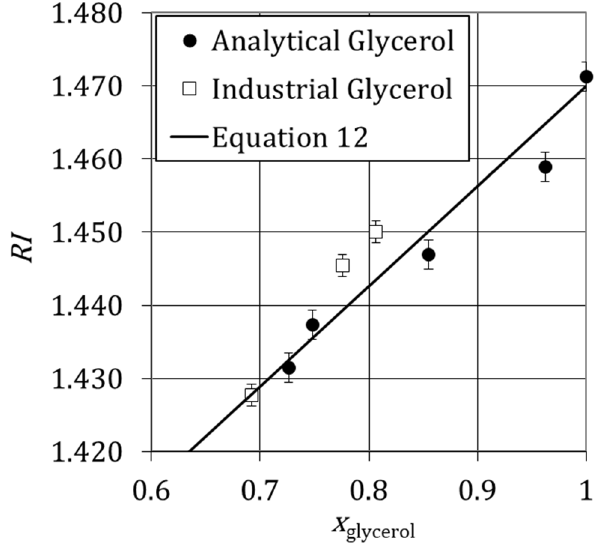
Figure 6. Variation of refractive index of analytical and industrial glycerol solutions with the mass fraction of glycerol at θ = 298.15 K measured experimentally (Analytical Glycerol and Industrial Glycerol) and determined from Equation (12).